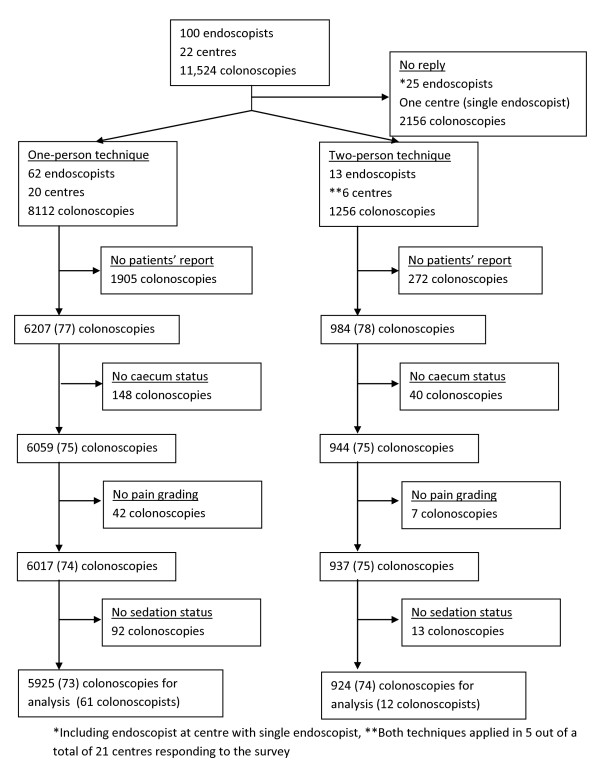
Flow chart displaying endoscopists, centres and colonoscopies in the survey (percent).